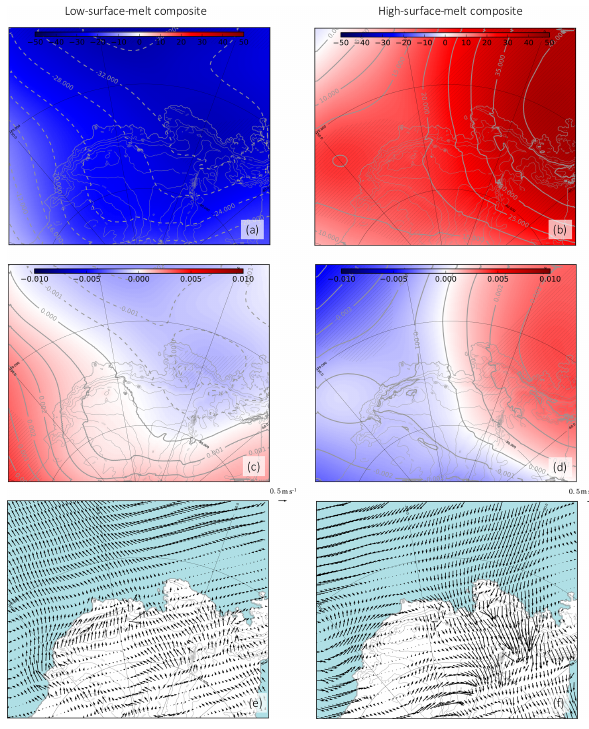
Figure 12. (a, b) The 500hPa geopotential height (m) and (c, d) 500hPa geopotential height divided by the domain-averaged value for each season and (e, f) 10m wind (ms − 1 ) anomalies dur- ing low-melt summers (left) and high-melt summers (right); scales of arrow lengths are shown near the upper right corner of panels (e) and (f) . Anomalies are calculated as high or low composites mi- nus the climatology over 1979–2017. The hatched area represents significance > 90% calculated with Welch’s t